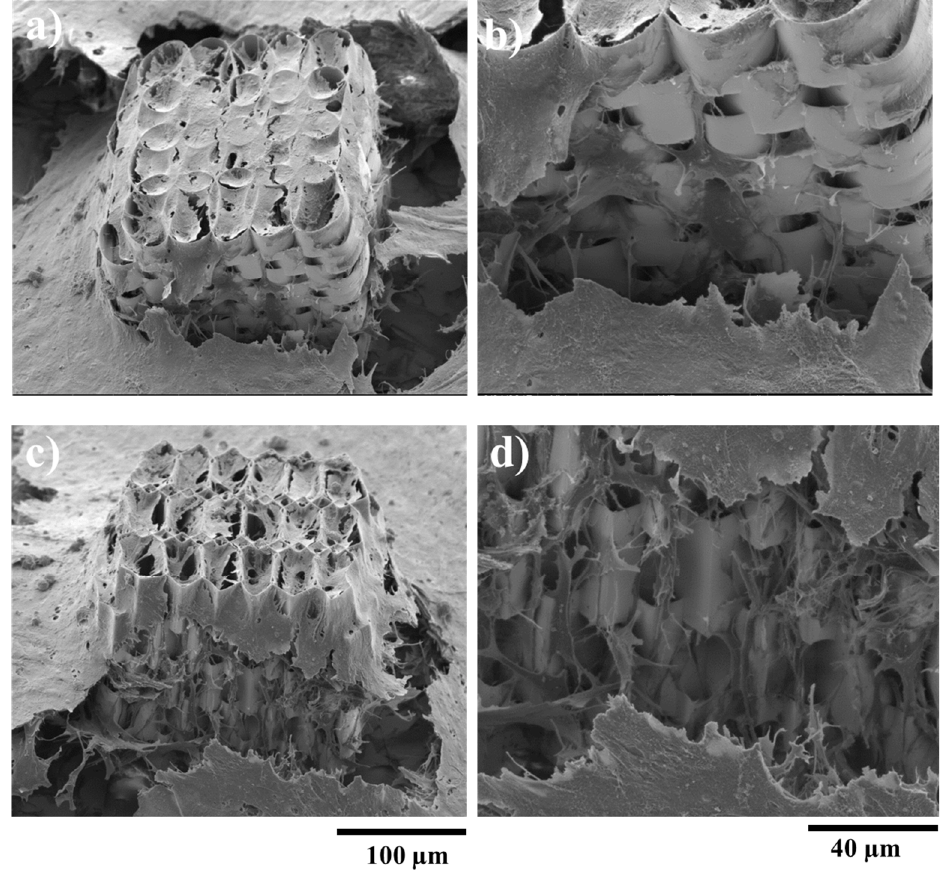
Figure 3. SEM (scanning electron microscopy) micrographs of MG-63 osteoblast like cells growing on ellipsoidal (upper panel) and hexagonal (lower panel) multilayered 3D structures with optimum horizontal arrangement, after 7 days in culture. ( a , c ) Overviews; ( b , d ) Cells growing on the lateral walls of the structures.